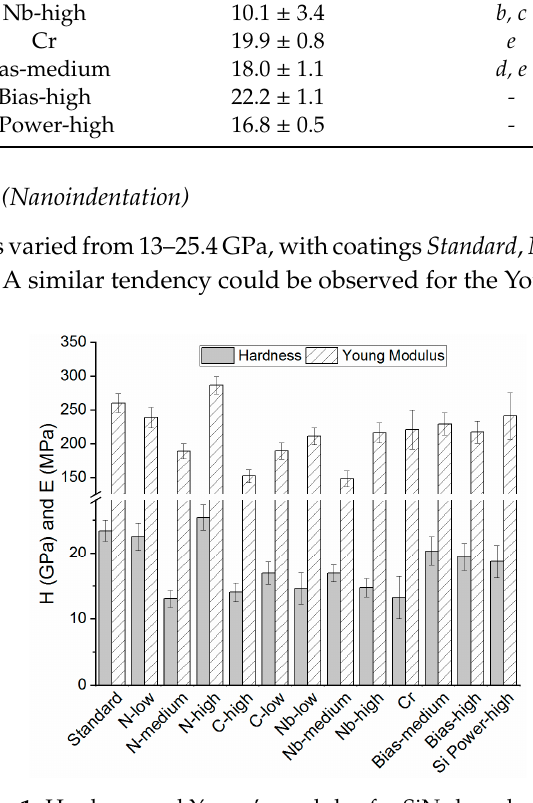
Figure 1. Hardness and Young’s modulus for SiN x based coatings.